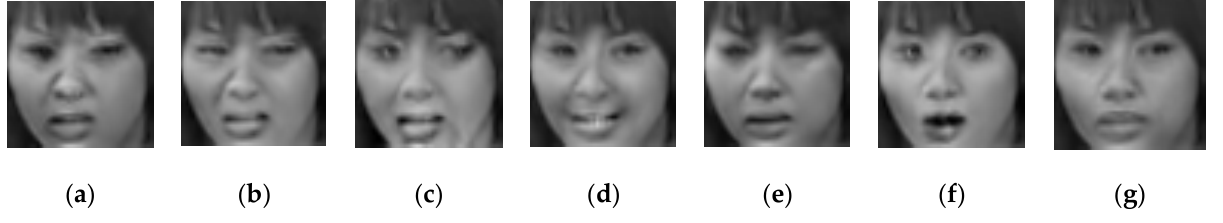
Figure 10. Seven kinds of facial expressions: ( a ) anger; ( b ) disgust; ( c ) fear; ( d ) happiness; ( e ) sadness; ( f ) surprise; ( g ) neutral.